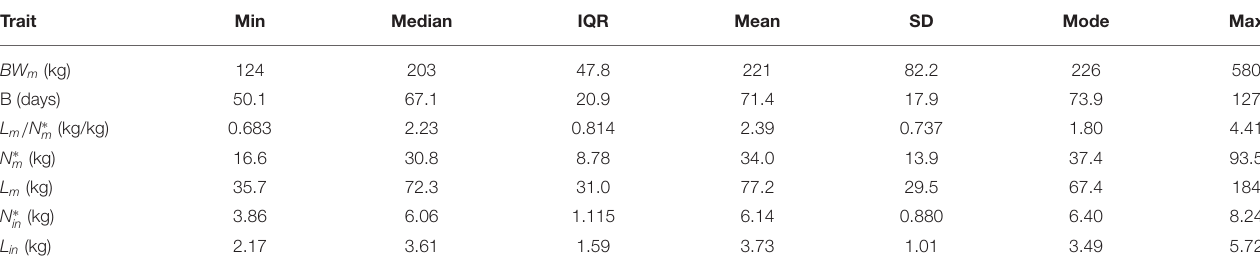
TABLE 2 | Summary statistics of the estimated traits across the thirty-two pigs in the population. Trait